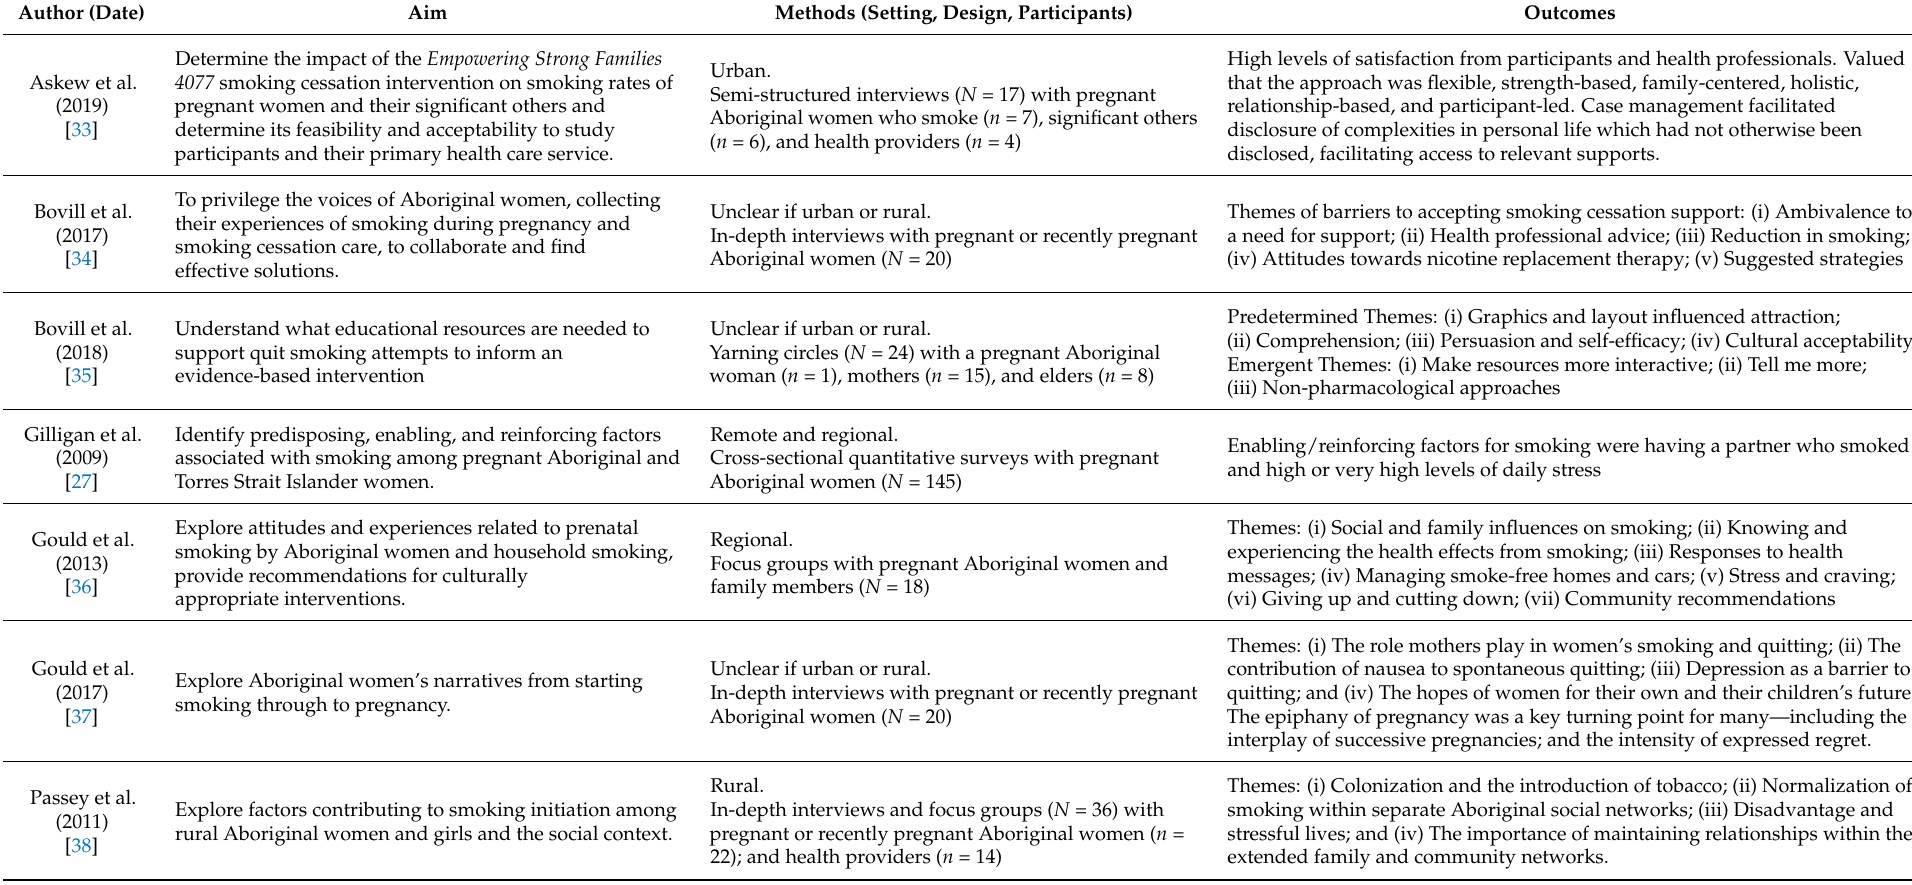
Table 2. Summary of health promotion materials and summary characteristics of included